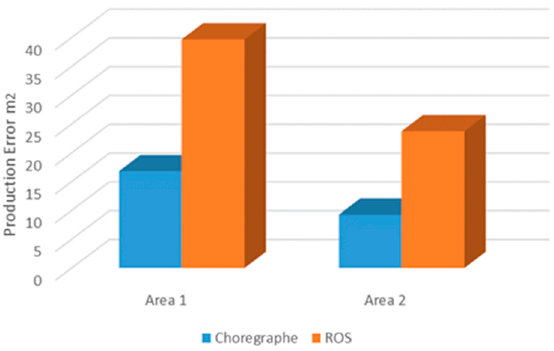
Figure 10. The average map production error for the two areas using Choregraphe and ROS.